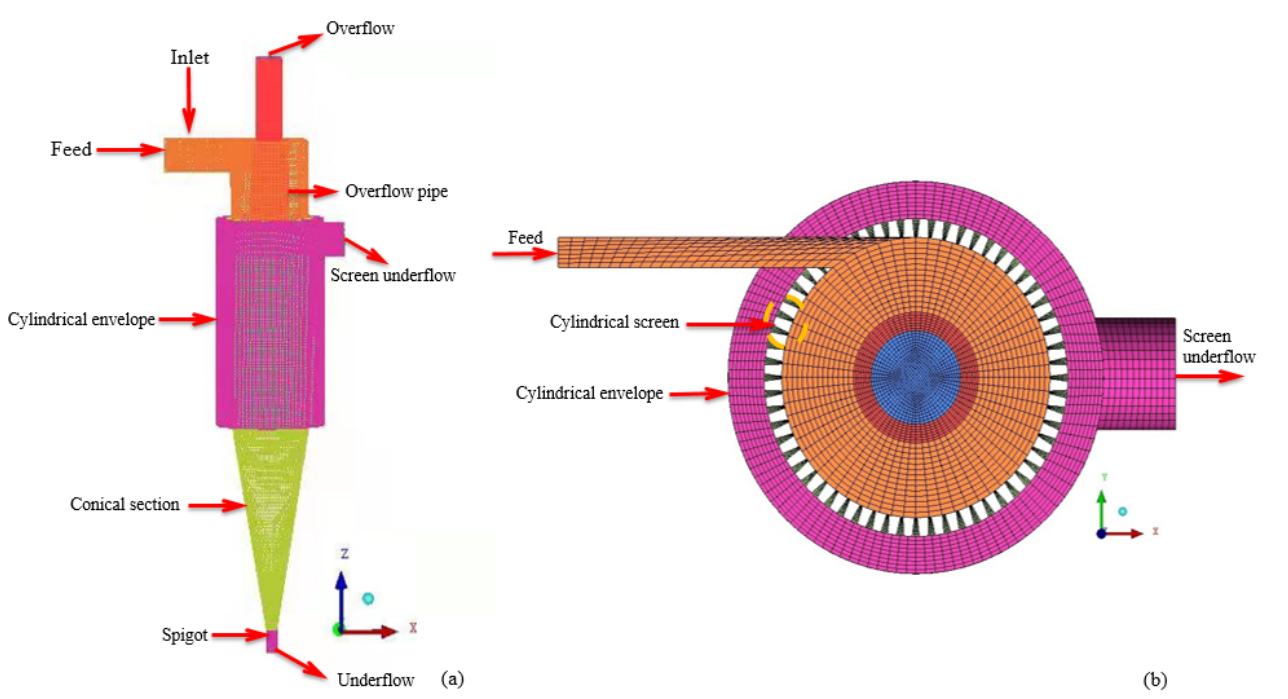
Figure 1. Diagram of 75 mm three products hydrocyclone screen (TPHS) ( a ) front view and ( b ) vertical view.